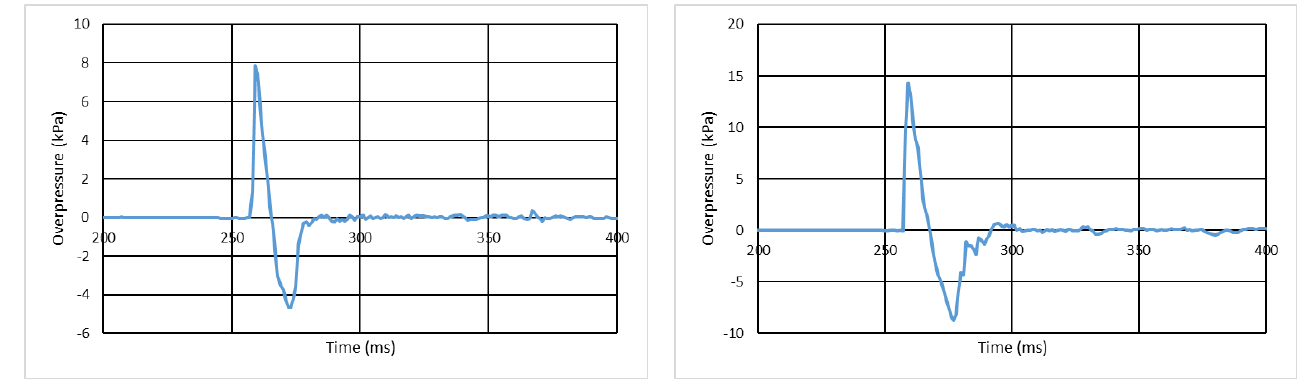
Figure 3. Air overpressure measured in tests no. 17 (left) and no. 37 (right). The graph in Figure 4 was obtained by representing the overpressure measured at each detonation against the scaled distance in logarithmic scales. It is clear that there is a linear relationship between the log( S b ) and the log( Z ), which means that there is a potential relationship between the variables S b (kPa) and Z (m/kg 1/3 ). By applying logarithms and a least squares adjustment, the following relationship was found: S b = 309.33 · Z − 1.216 (3) with a high correlation coefficient r 2 = 0.96. This is in accordance with the first experiences in this field [10].